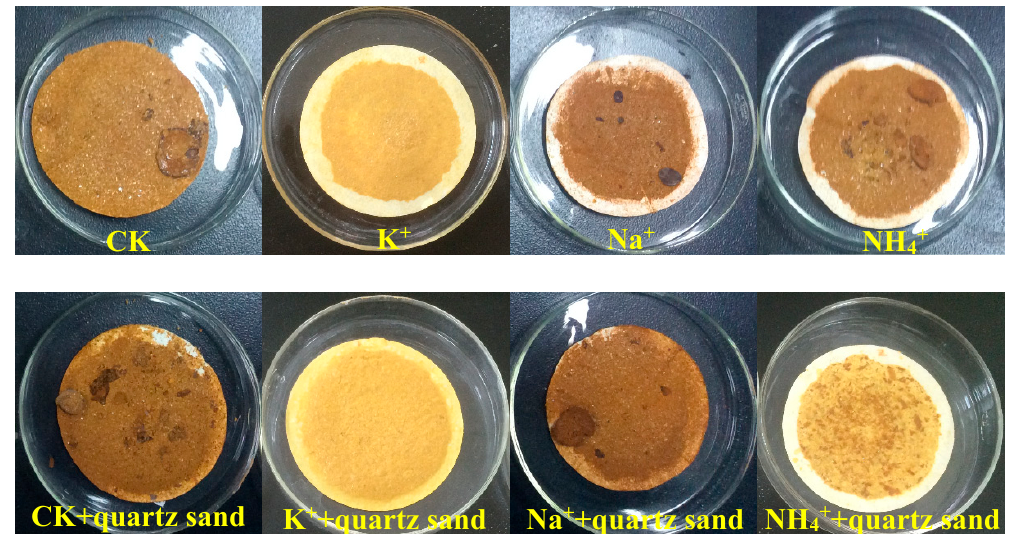
Figure 4. Photographs of the secondary iron minerals for different biomineralization treatments.